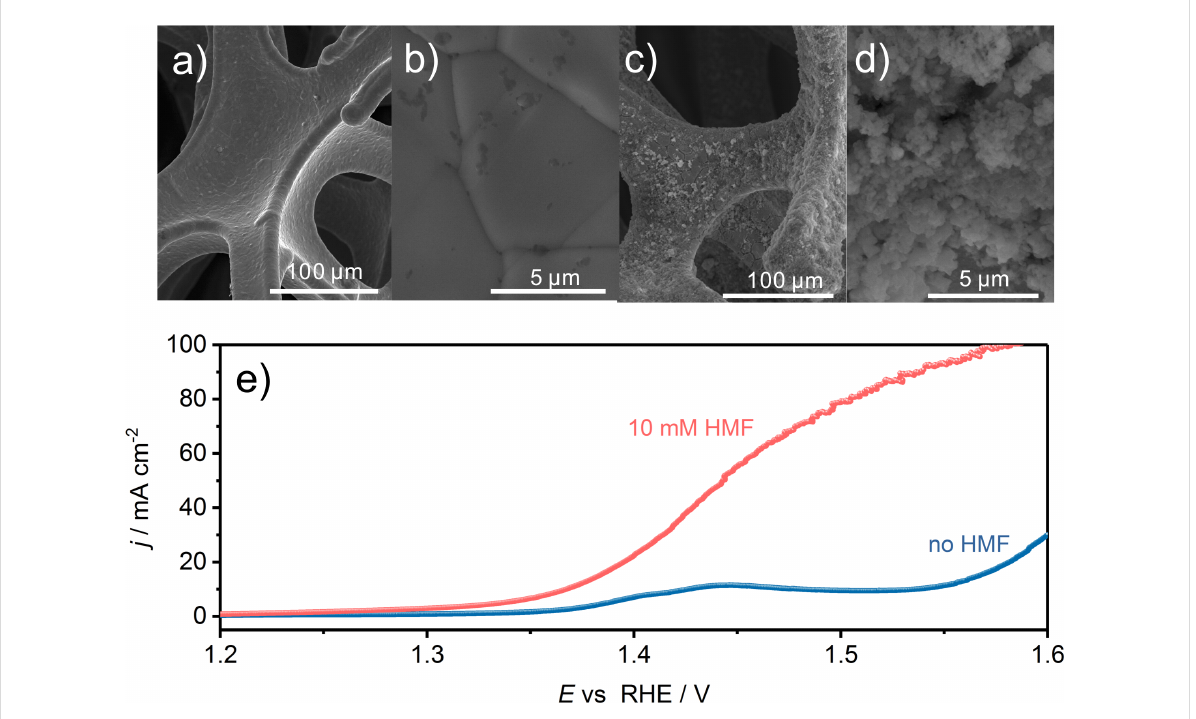
Figure 3: SEM micrographs of bare (a, b) and CoB-modified (c, d) NF with 1000× or 20000× magnification, respectively. e) LSVs of CoB modified NF in the absence and presence of HMF (10 mM) in the flow reactor (1 M KOH, 2 mV s − 1 , 18 mL min − 1 ).